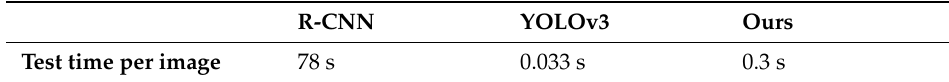
Table 3. Comparison of detection